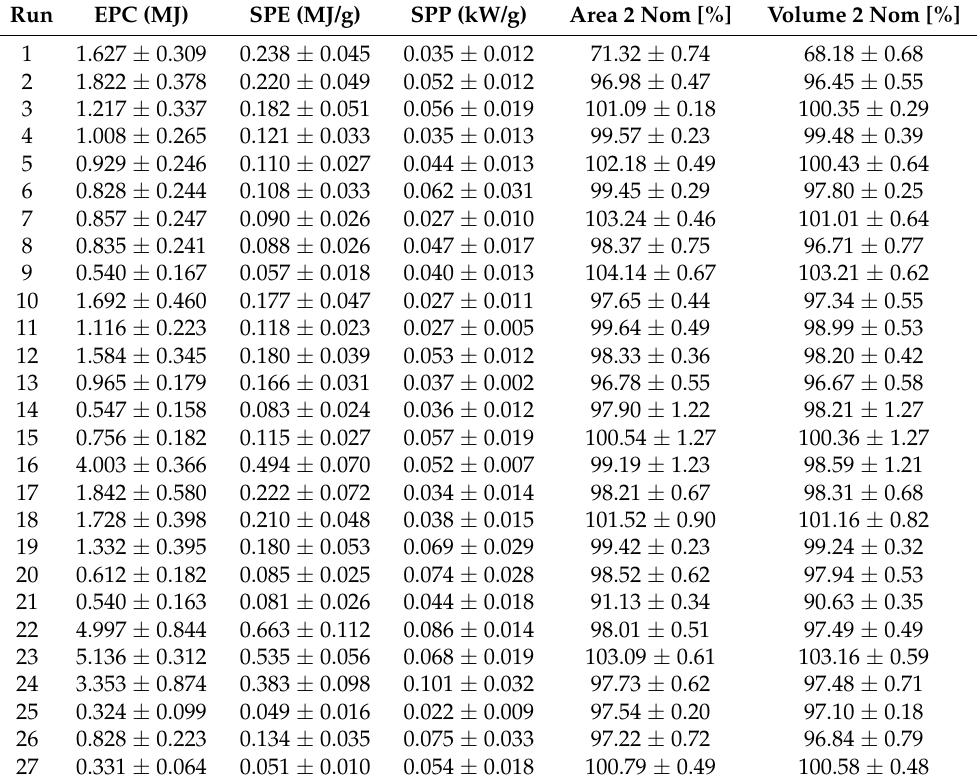
Table 3. Mean average values and standard deviations of measured responses for EPC, SPE, SPP, area to nominal, and volume to